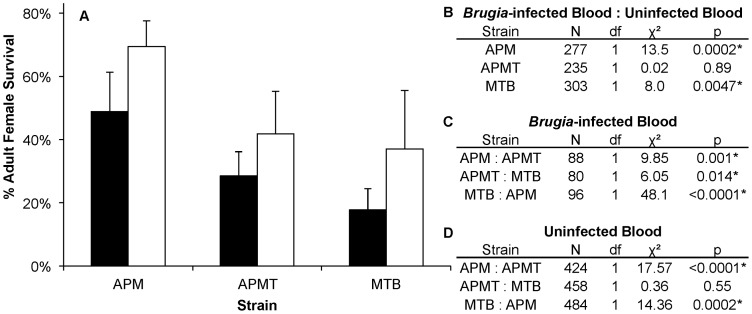
Survivorship of Ae. polynesiensis strains after feeding on Brugia-infected blood vs. uninfected blood.A) Mean survivorship of APM, APMT and MTB ten days after feeding on Brugia pahangi-infected blood (black) vs. uninfected blood (white). The presence of Brugia pahangi in the blood meal was associated with decreased survivorship for APM (p<0.05) and MTB (p<0.05). APMT survivorship was independent of blood meal type (p = 0.89). Error bars represent standard error for three replicates. B) Contrast comparisons for strains fed Brugia-infected and uninfected blood. C) Contrast comparisons for strains fed Brugia-infected blood. D) Contrast comparisons for strains fed uninfected blood.